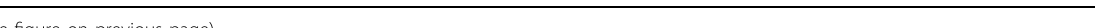
(see fi gure on previous page) Fig. 2 Knockdown of lncRNA SOX2OT inhibits the tumorigenicity of CRC cells in vitro. A CCK-8 assay was performed to determine the cell viability of HT29 and SW480 cells transfected with SOX2OT-shRNAs or negative control (Con-shRNA). B EDU assay was performed to measure the cell proliferation of HT29 and SW480 cells transfected with SOX2OT-shRNAs or negative control (Con-shRNA), scale bar = 50 μ m; Transwell assays were conducted to showed cell migration and invasion in HT29 and SW480. C , D Cells transfected with SOX2OT-shRNAs or negative control (Con-shRNA), scale bar = 50 μ m. E Cell cycles were analyzed with Flow cytometry in transfected HT29 and SW480 cells. F Transfected HT29 and SW480 cells were respectively applied to western blot to detect the expression levels of E-cadherin, N-cadherin,vimentin, and fi bronectin. *** P < 0.001 vs. Con-shRNA. Data were expressed as mean ± SD. All experiments were repeated three